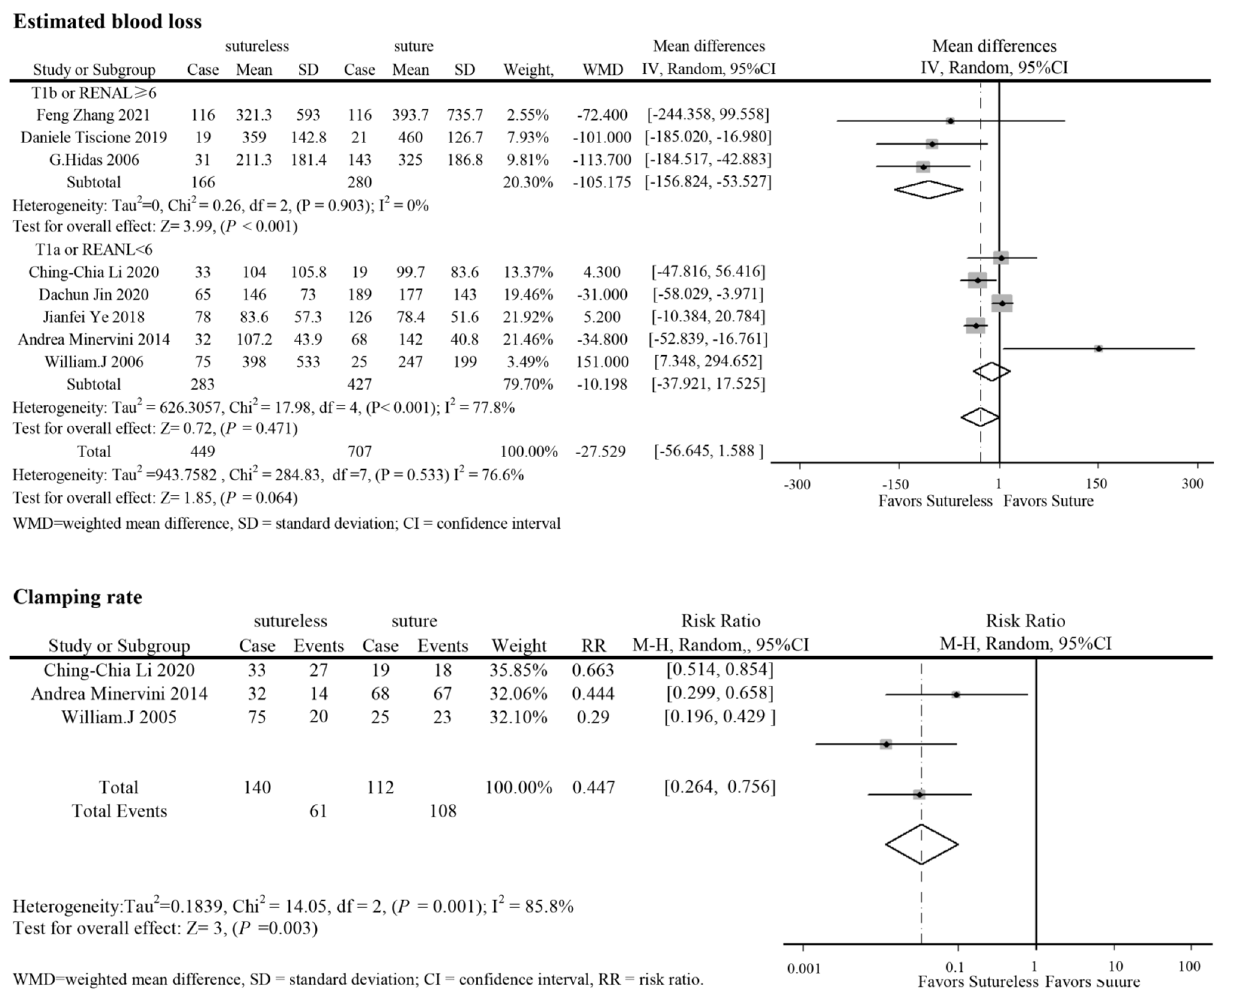
FIGURE 3 | Forest plots of estimated blood loss and clamping rate for sutureless versus suture partial